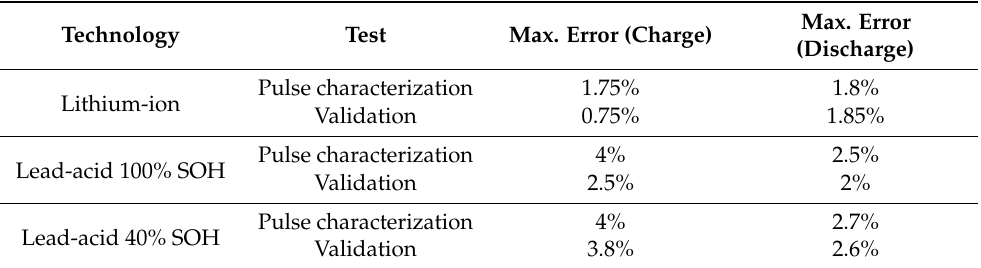
Table 2. Relative error results in pulse characterization and validation tests for lithium-ion and lead-acid